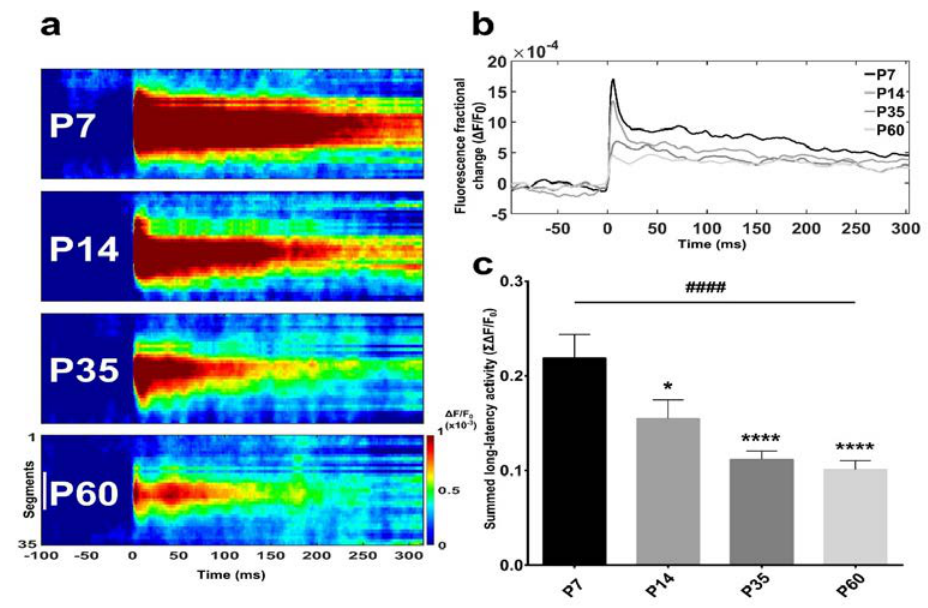
Figure 2. BF-evoked activity decrease is age-dependent. ( a ) Spatiotemporal analysis of BF-evoked response to stimulation. VSDI (voltage-sensitive dye imaging) data are shown as ‘space-time’ arrows of activity consisting of a bi-dimensional map defined by a hand-selected region of interest (see Figure 1j) over time (300 ms after the delivery of stimulus at T = 0 ms). The colour scale at the bottom indicates depolarizations as warm colours and hyperpolarisations as dark colours. The white scale bar at the bottom in ( a ) is 1 mm; colour bar units: ΔF/F 0 . Space-time maps relative to the four postnatal developmental stages show a reduction in assembly size. ( b ) Averaged response-time series from different age groups. Comparison of superimposed VSDI traces displaying a clear decrease in fluorescence fractional change from infant (P7) to young adult (P60) stage. ( c ) Bar graph indicating that the quantification of averaged summed fluorescence fractional change relative to P7, P14, P35 and P60 animals presented a significant decreasing trend between groups (trend analysis post-hoc test). Moreover, major variation were observed between P7 rats and older age-groups (Bonferroni’s post-hoc test). Asterisks indicate a difference between P7 and the other groups (Bonferroni’s post-hoc test), while hashes represent the linear trend among groups (trend analysis post-hoc test). Data are the mean ± SEM, n = (hemislices, rats): P7 = (30, 5); P14 = (31, 5); P35 = (33, 5); P60 = (30, 5). * p < 0.05, **** ,#### p < 0.0001.